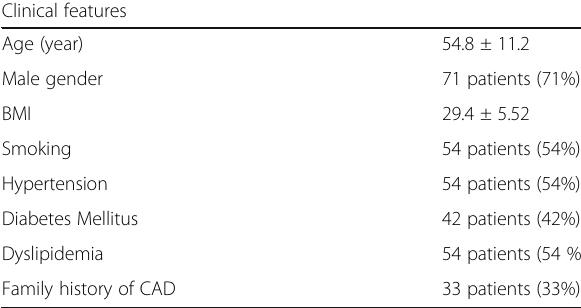
Table 1 Demographic data of studied